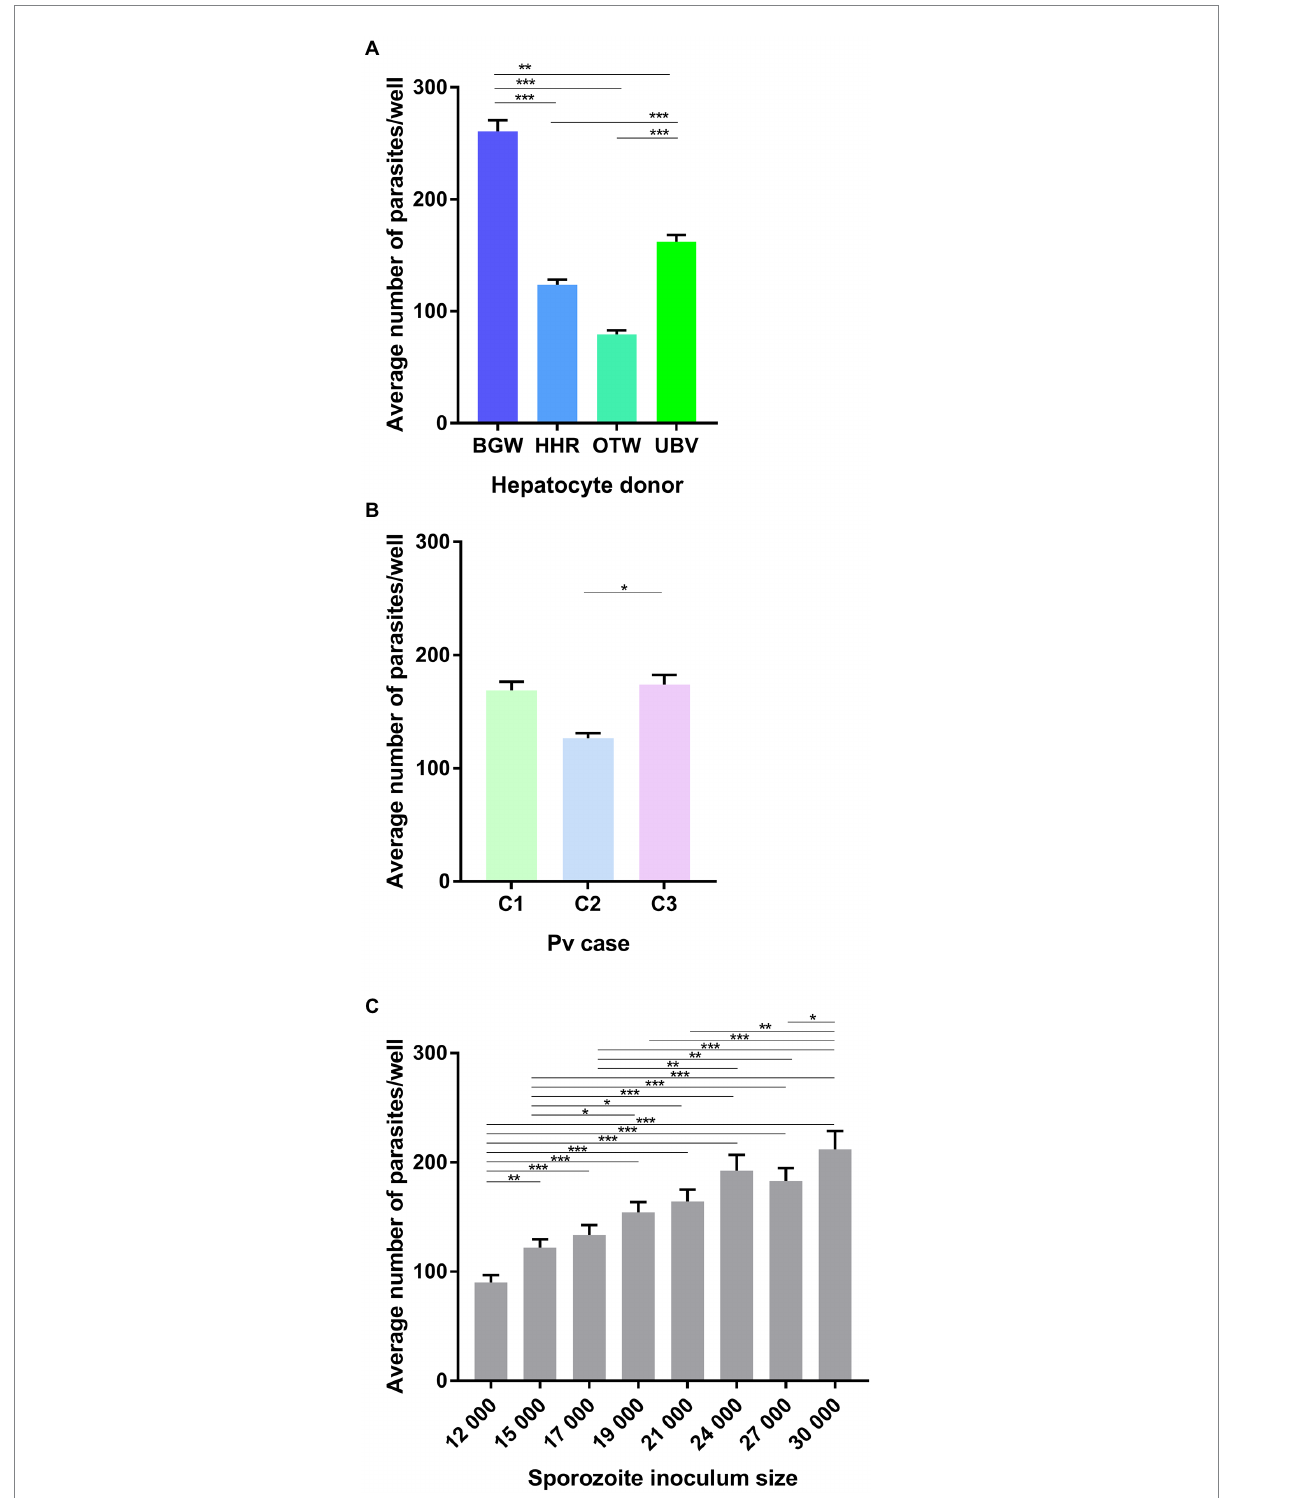
FIGURE 1 Analysis of the average number of Plasmodium vivax parasites per well. Data include all parasites quantified from Experiment 1 in which four PHH donor lots (UBV, BGW, HHR, and OTW) were infected with three different P. vivax cases (C1–C3) at eight sporozoite densities ranging from 12 × 10 3 to 30 × 10 3 per well and fixed at 8 days post-infection. Data are categorized by (A) PHH donor lot, (B) P. vivax isolate, and (C) sporozoite inoculum size. Asterisks indicate significant differences ( Post hoc Tukey’s pairwise comparisons, *** p < 0.0001, ** p < 0.001, * p < 0.05). Bars represent ±